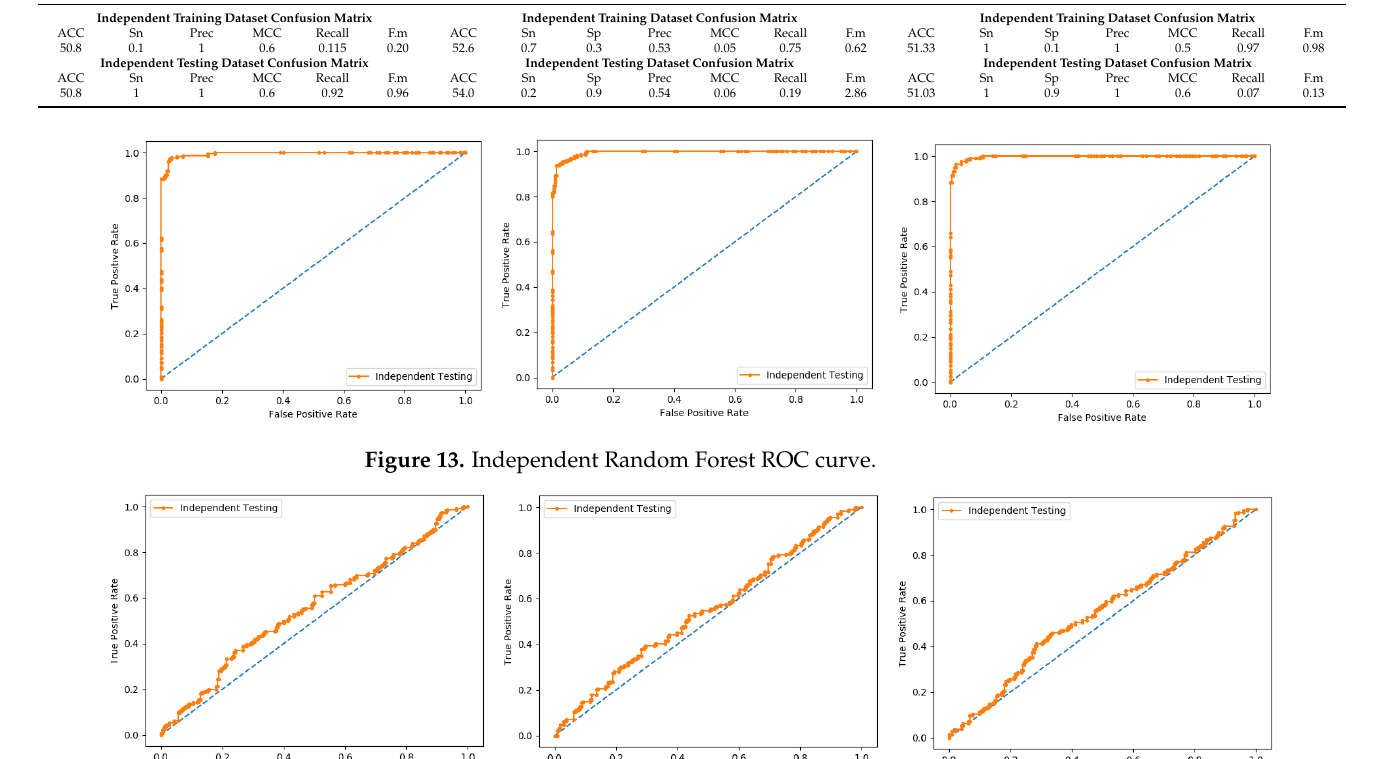
Figure 13. Independent Random Forest ROC curve. Table 9. Result of independent test based on Probabilistic Neural Network.